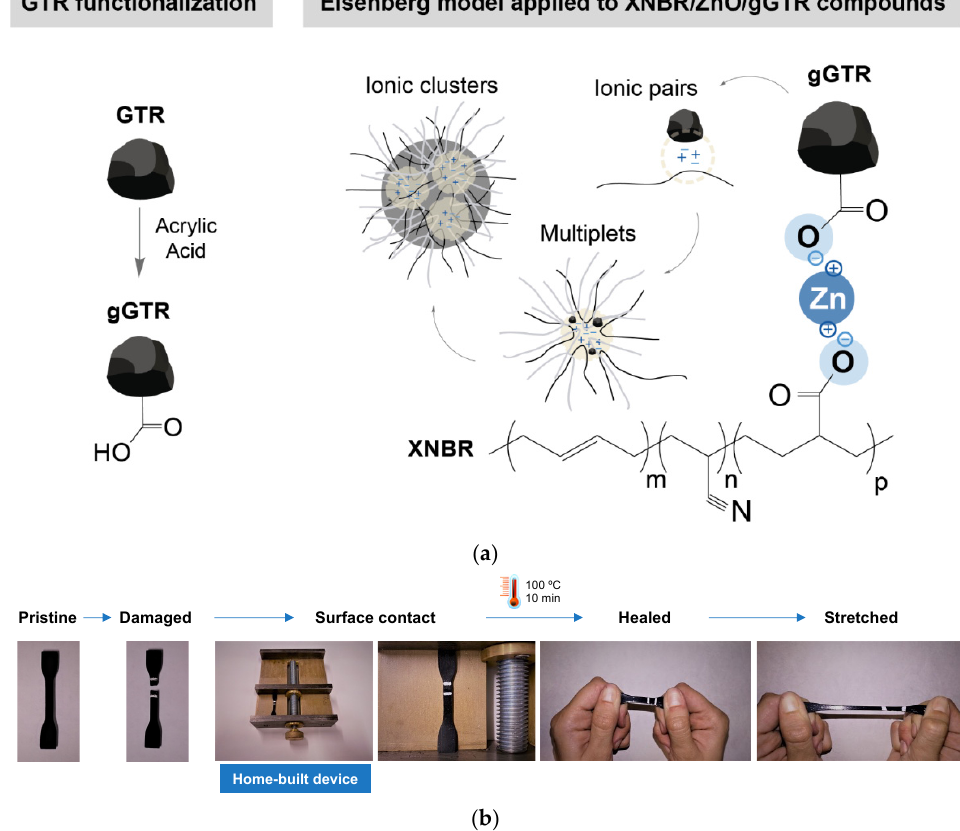
Figure 11. ( a ) Scheme of ionic interactions in XNBR/ZnO/gGTR compounds, ( b ) home-built device used for self-healing tests. Adapted with permission from [79]. 2020, Elsevier.